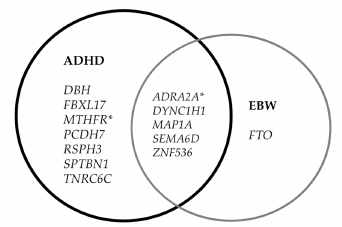
Figure 2. Venn diagram representing common and shared genes between ADHD and EBW. * genes associated with ADHD by SNP